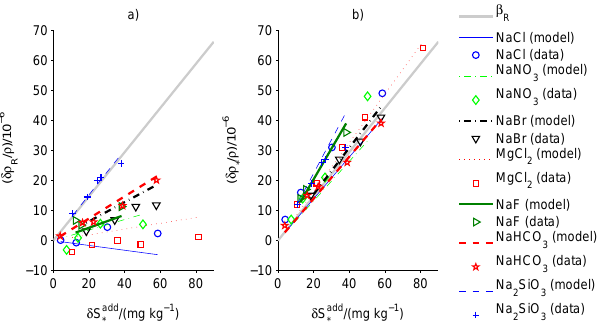
Fig. 4. Laboratory measurements (data) and model predictions (model) for relationships between added mass δS add ∗ and density anomalies (a) δρ R /ρ and (b) δρ ∗ /ρ for different added salts. Thick gray line shows slope β R